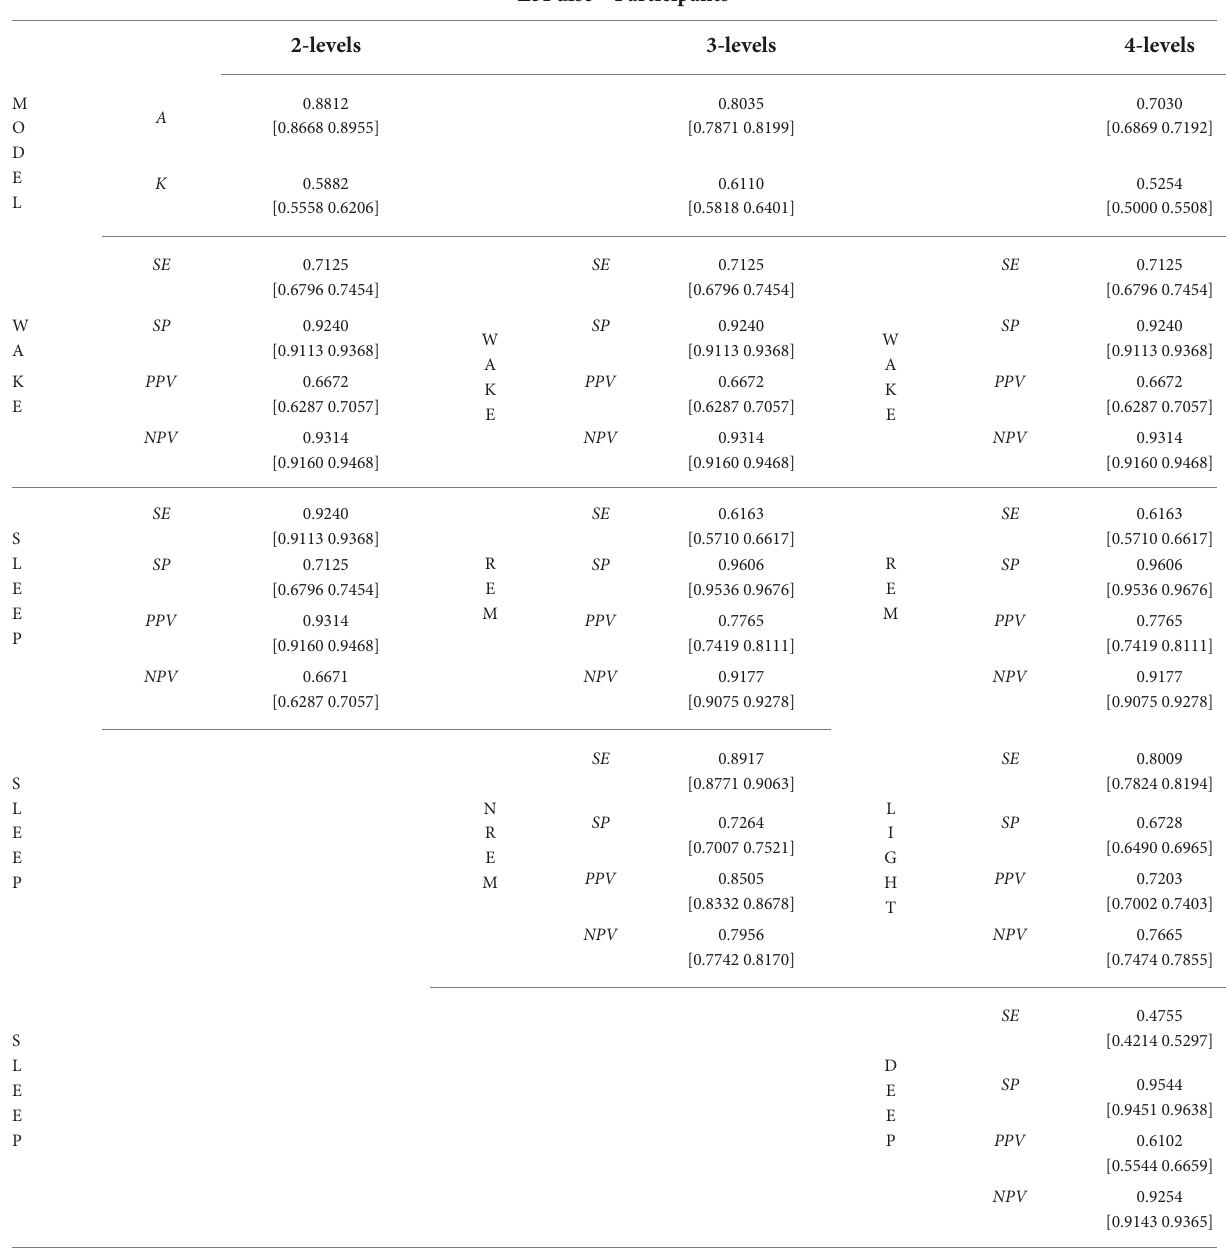
TABLE 4 Mean and [95% confidence Intervals] Accuracy (A), Cohen’s kappa (K), Sensitivity (SE), Specificity (SP), Positive Predictive Value (PPV), and Negative Predicted Value (NPV) were obtained by firstly collapsing metrics within and subsequently across participants in the Z3Pulse